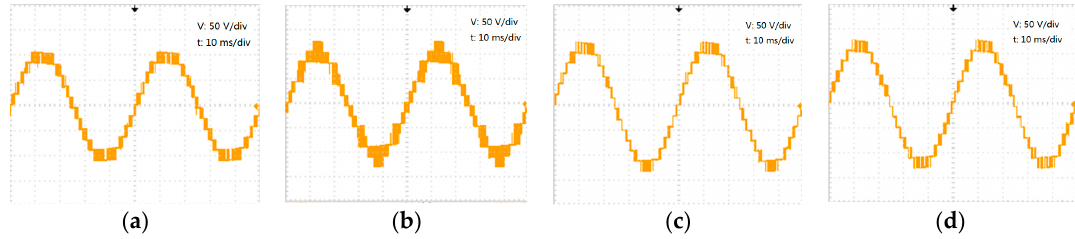
Figure 24. Line-to-line voltage of 7-level inverter with different PWM schemes, ( a ) IPDPWM; ( b ) PSPWM; ( c ) classical SVPWM; ( d ) proposed SVPWM.